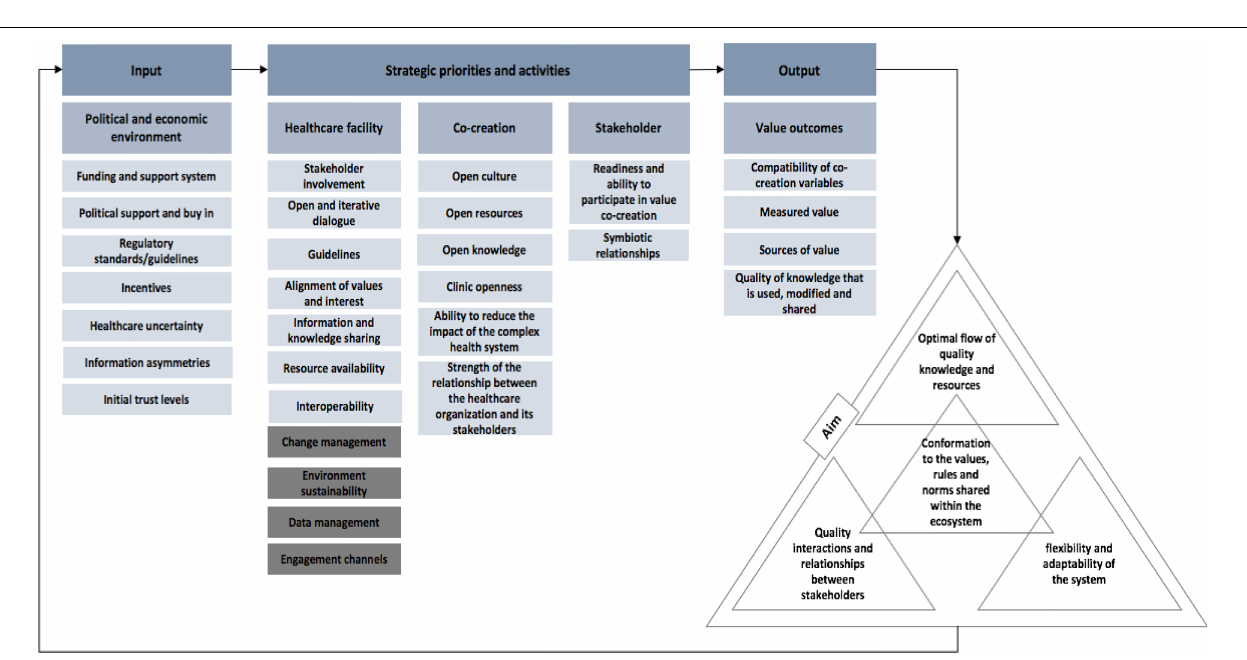
FIGURE 4 | Preliminary